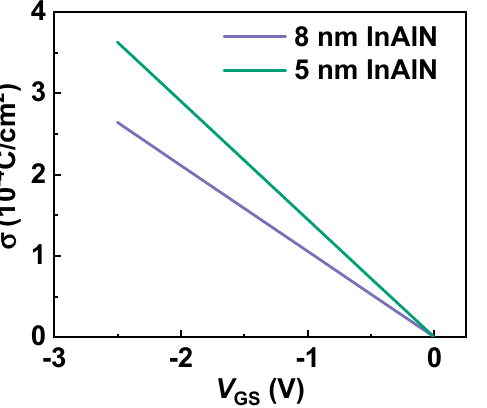
Figure 8. Schematic of the additional polarization charge ( σ ) distribution in InAlN barrier.